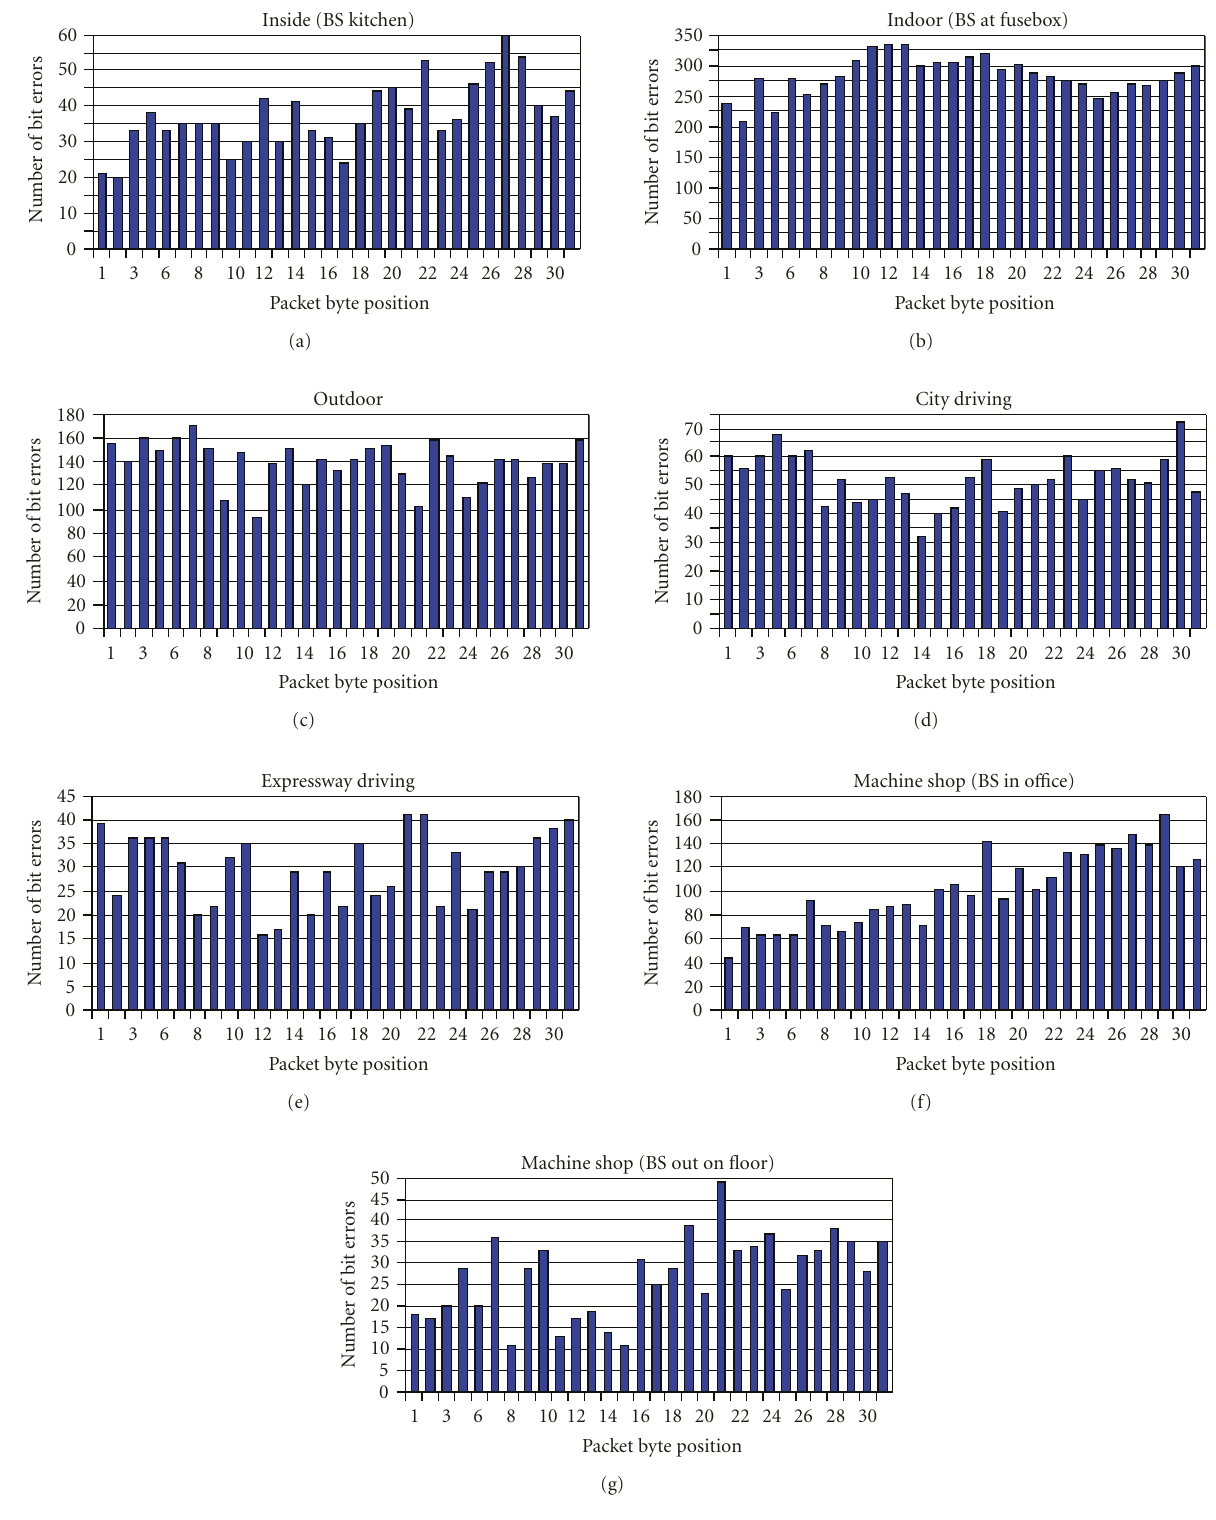
Figure 7: Bit error histograms broken down by their byte position within the data